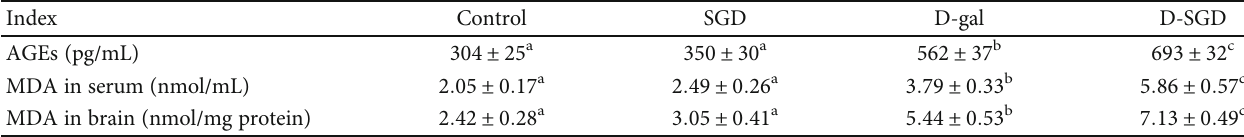
Table 1: E ff ects of serine de fi ciency on levels of AGEs and MDA in D-galactose-treated mice.